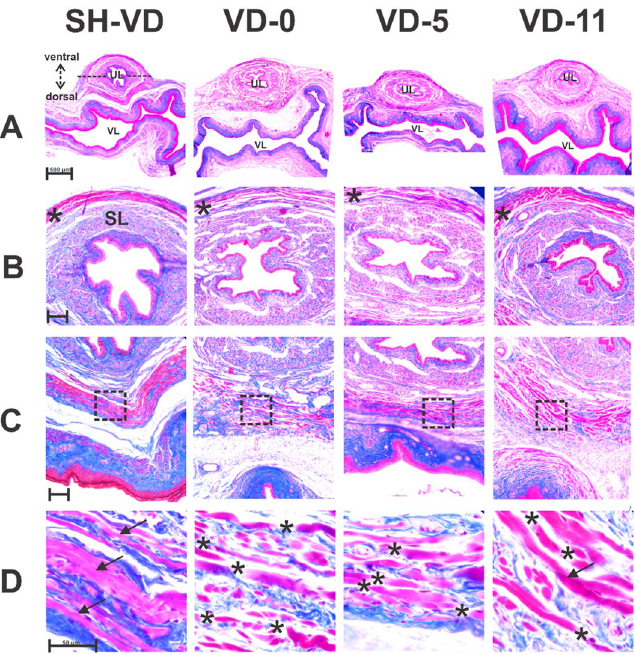
Figure 3. Photos of transverse sections of the urethra of female rats showing time course of structural injuries and recovery after vaginal distension (VD). Sections are stained with Masson´s trichrome and amplified at 5x ( A ), 20x ( B , ventral side; C , dorsal side) and 100x ( D ) magnification. SH-VD, Sham VD; VD-0, immediately after VD; VD-5, at day 5 after VD; VD-11, 11 days after VD. In ( B ), asterisks indicate transverse fibers on the ventral side of the EUS. Photomicrographs in panels D correspond to magnifications of the squares indicated in ( C ), showing the dorsal side of the EUS. Black arrows in ( D ) indicate continuous striated muscle fibers of the EUS, while asterisks in ( D ) indicate discontinuities in EUS muscle fibers. VL, vaginal lumen; SL, smooth muscle; UL, urethral lumen. Scale bars: ( A ) 500 µm; ( B ) 100 µm; ( C ) 100 µm; ( D ) 50